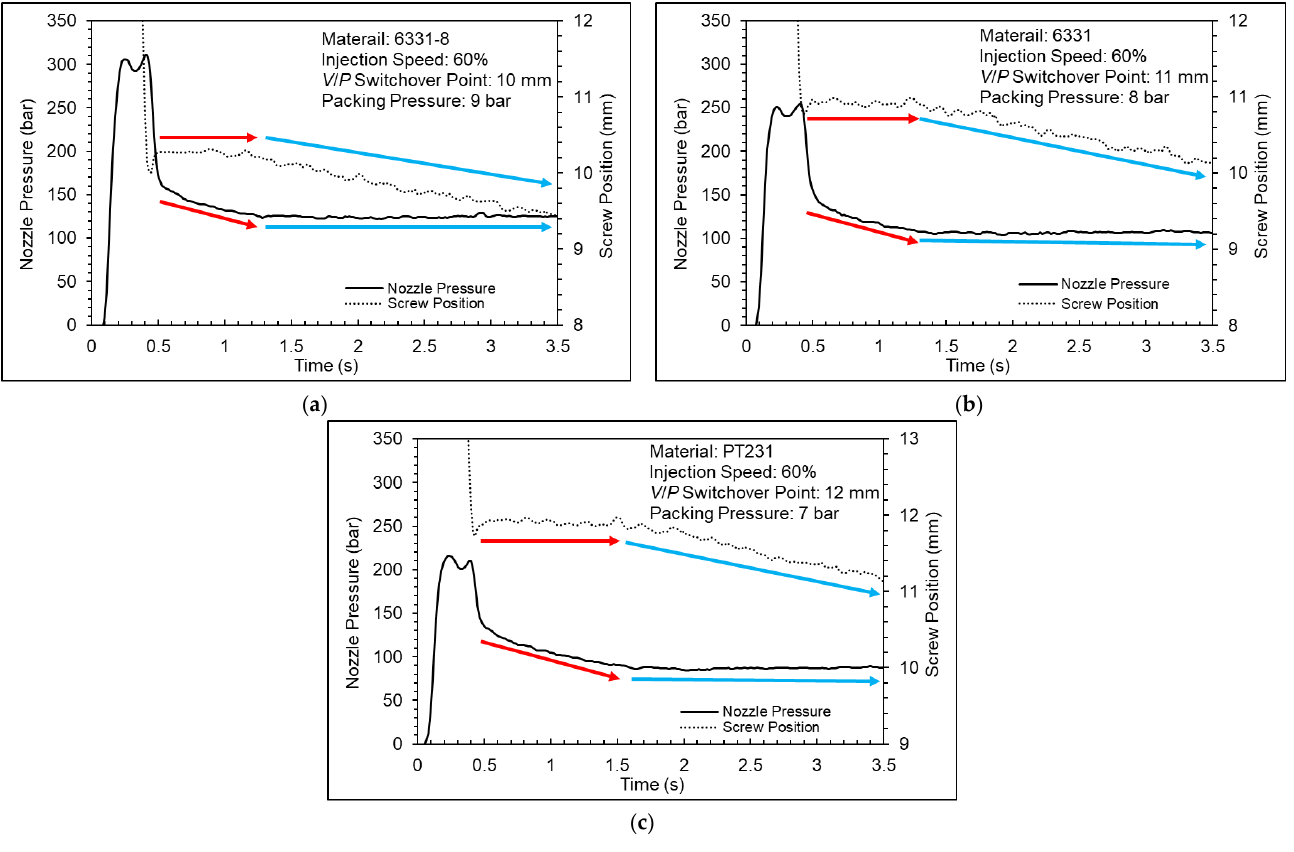
Figure 17. Nozzle pressure profile and screw stroke profile (( a ) 6331 − 8, ( b ) 6331, and ( c ) PT231).